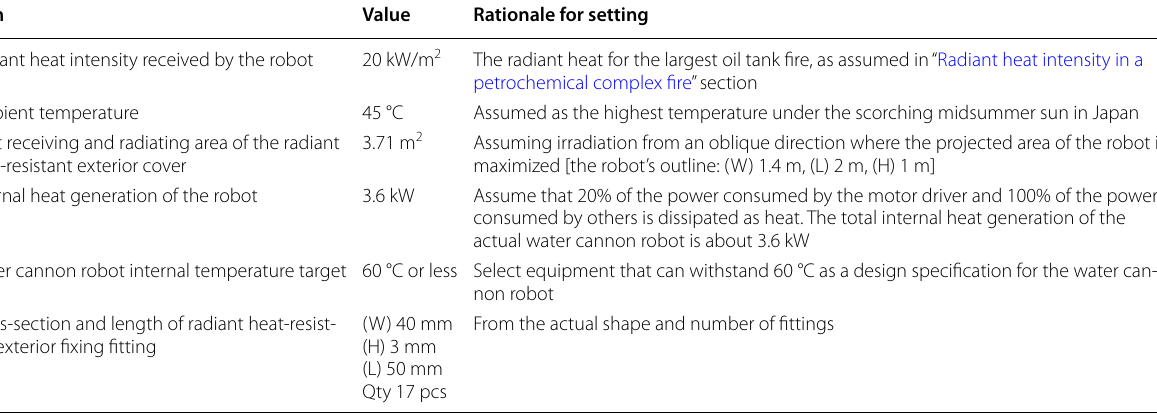
Table 6 Design conditions for water cannon robots Item Value Rationale for setting Radiant heat intensity received by the